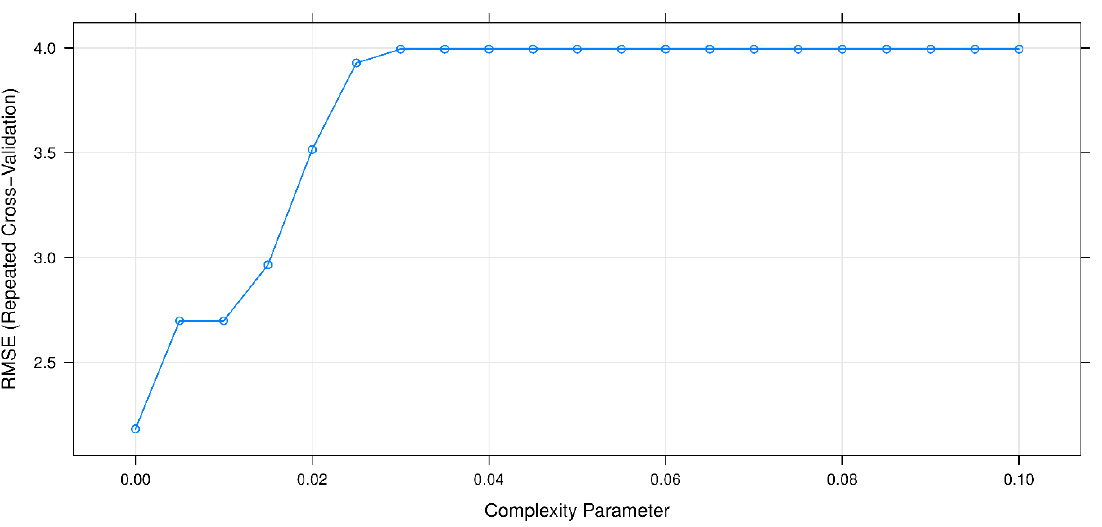
Figure 10. The development process of the classification and regression trees (CART) model for estimating HL.